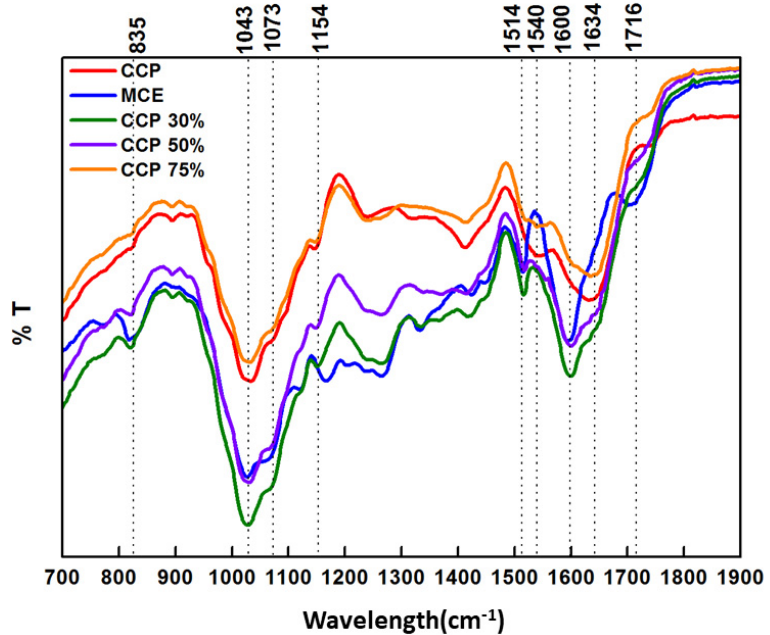
Figure 5. FT-IR spectra. CCP spectrum was red line, MCE blue line, MCE-CCP 30/70 green line, MCE-CCP 50/50 purple line, and MCE-CCP 75/25 orange line.